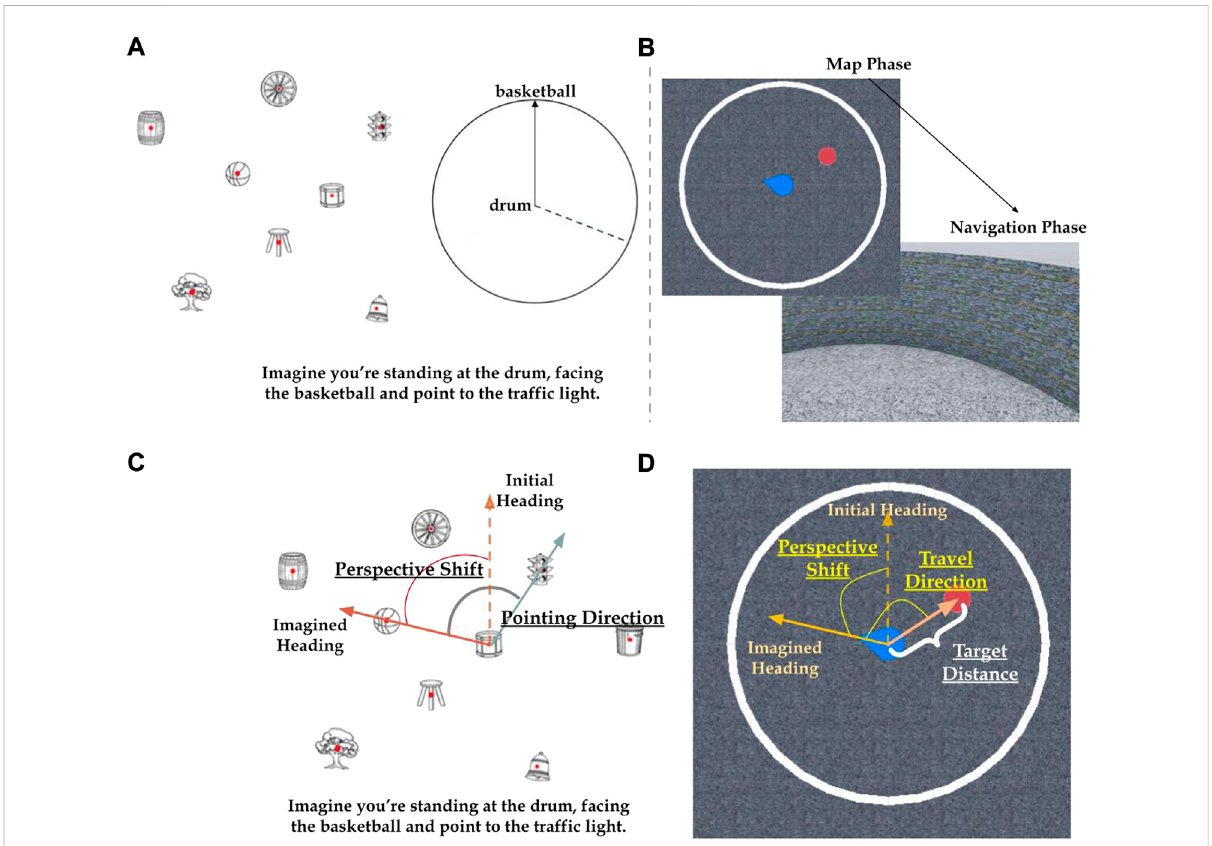
FIGURE 1 Sample trials for (A) the Spatial Orientation Task, with the correct answer shown in the dotted line and (B) the immersive Viewpoint TransformationTask; (C,D) showstheirtrialfeatures.PerspectiveShiftisthedifferenceinanglebetweentheinitialheadingandtheimaginedheading required by each trial, (C) Pointing Direction is the difference in angle between the imagined heading and the target, and (D) Travel Direction is the difference in angle between the imagined heading and the target. Finally, Target Distance is the straight-line distance translation from the participant ’ s standing location to the target